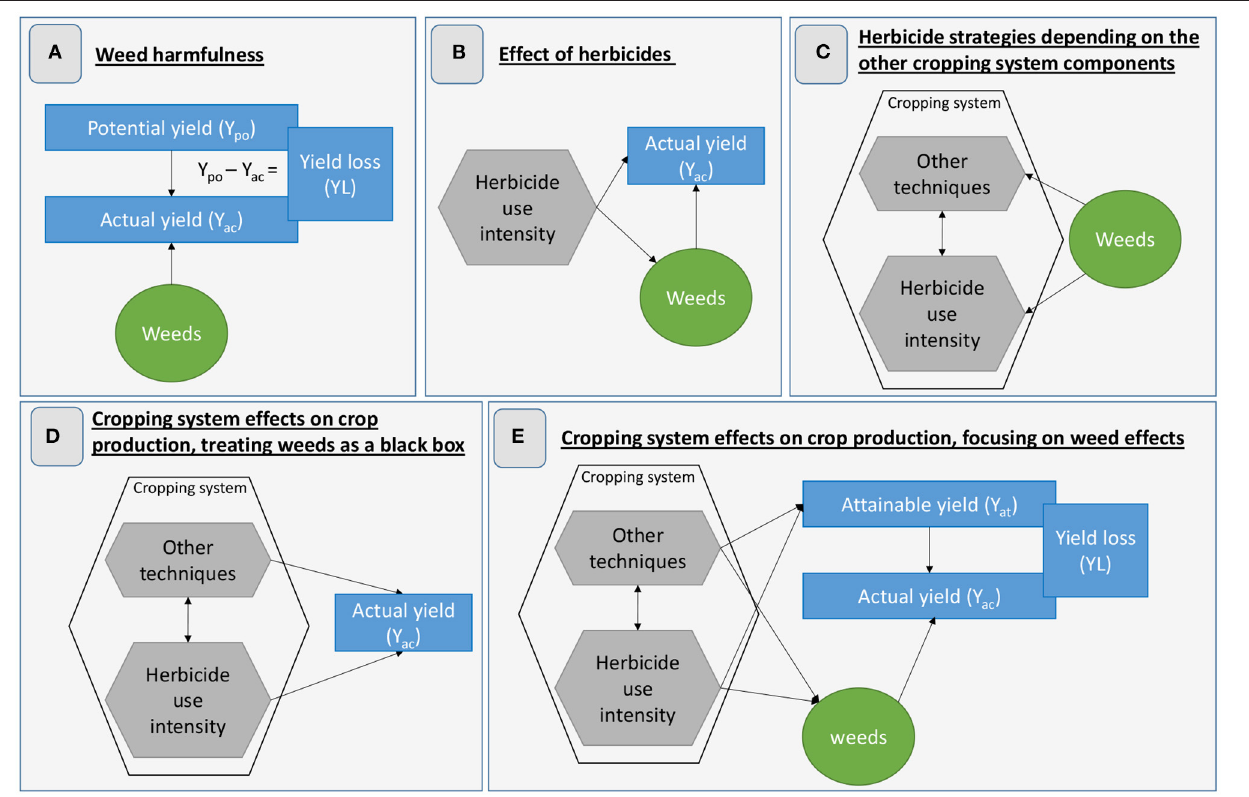
FIGURE 1 | Methodological framework used in the present study to determine the typology of studies investigating the relationships between farming practices including herbicides (gray octagons), weeds (green ovals), and crop yield (blue rectangles). (A) Weed harmfulness (section How Crop:Weed Interference Is Quantified), (B) Effect of herbicides (section Effect of Herbicides on Crop Production), (C) Herbicide strategies depending on the other cropping system components (section How Far Farmers Adapt Their Herbicide Strategies to the Other Farming Practices); (D) Cropping system effects on crop production, treating weeds as a black box